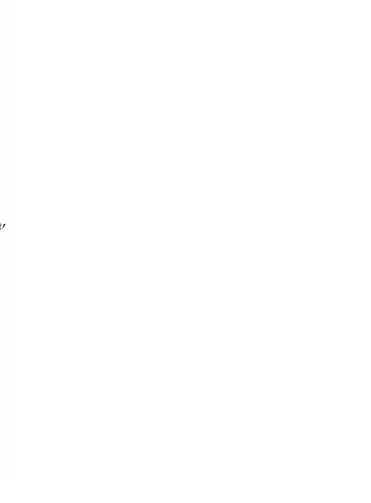
Figure 12. Solution methodology flow